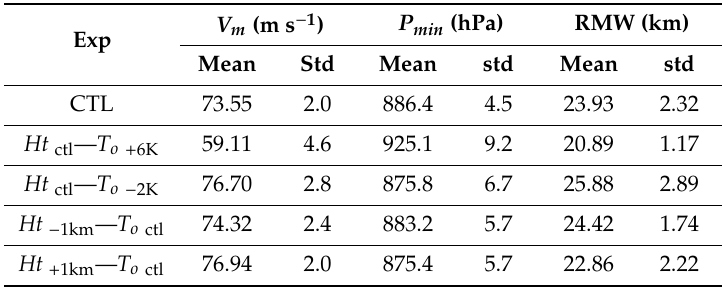
Table 3. The mean and standard deviation (std) of maximum winds V m , central pressure P min , and radius of maximum winds (RMW) during the equilibrium states. Experiments shown in Figures 5 and 6 are chosen here.